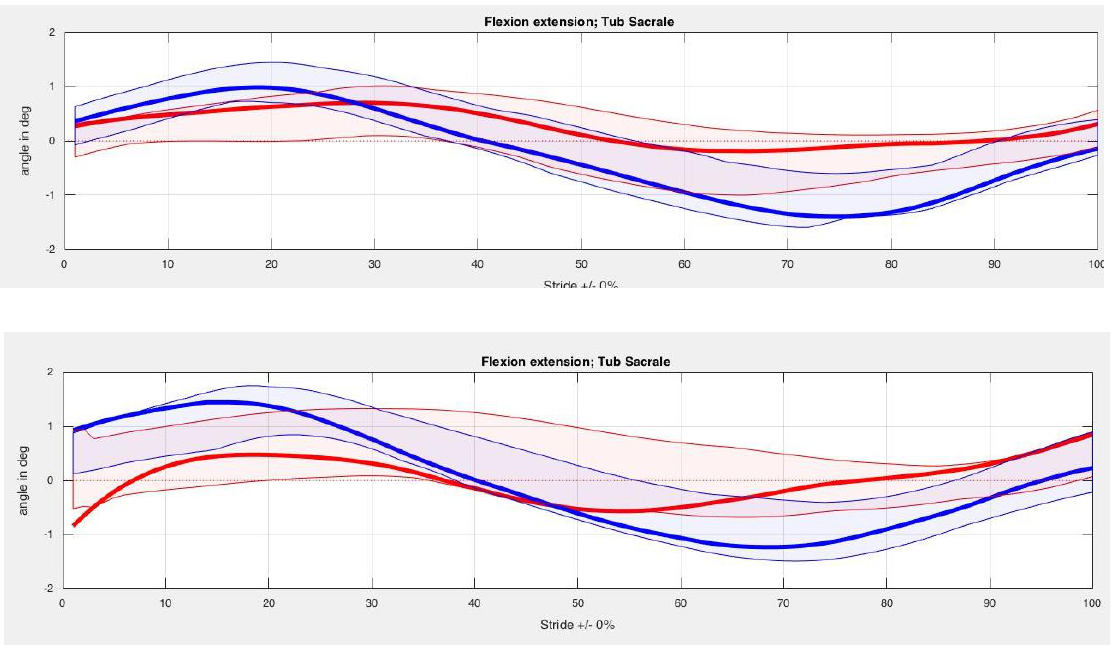
Figure A1. Flexion-extension angular patterns of the tuber sacrale of horse no. 4 (mean stride) at trot without kinesiotape (the upper graph) and with kinesiotape (the lower graph). The thickened line indicates the mean, shaded area the standard deviation. Left hindlimb red and right hindlimb blue.